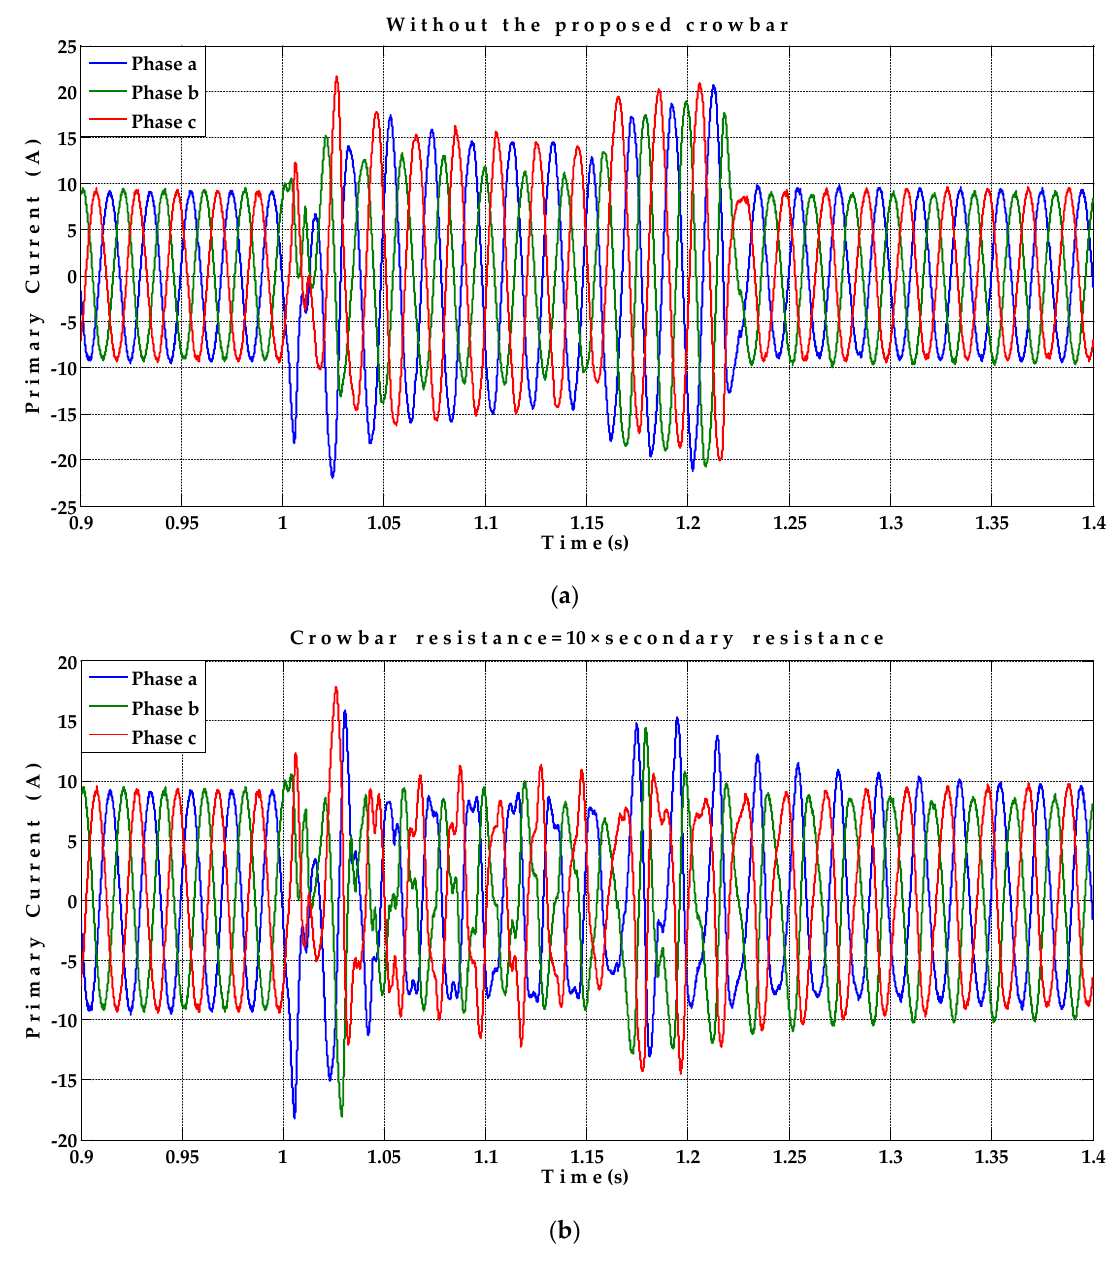
Figure 34. Primary current of BDFRG without and with the proposed crowbar under double line to ground fault occurrence: ( a ) Without the proposed crowbar; ( b ) With the proposed crowbar.